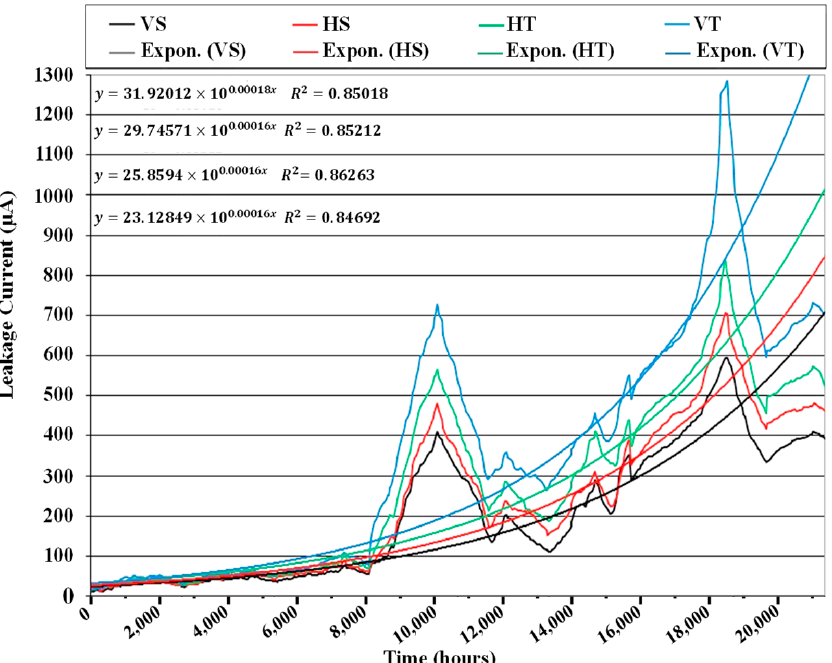
Figure 10. Exponential regression on results of leakage current. Table 3. Values of R taken from regression techniques.